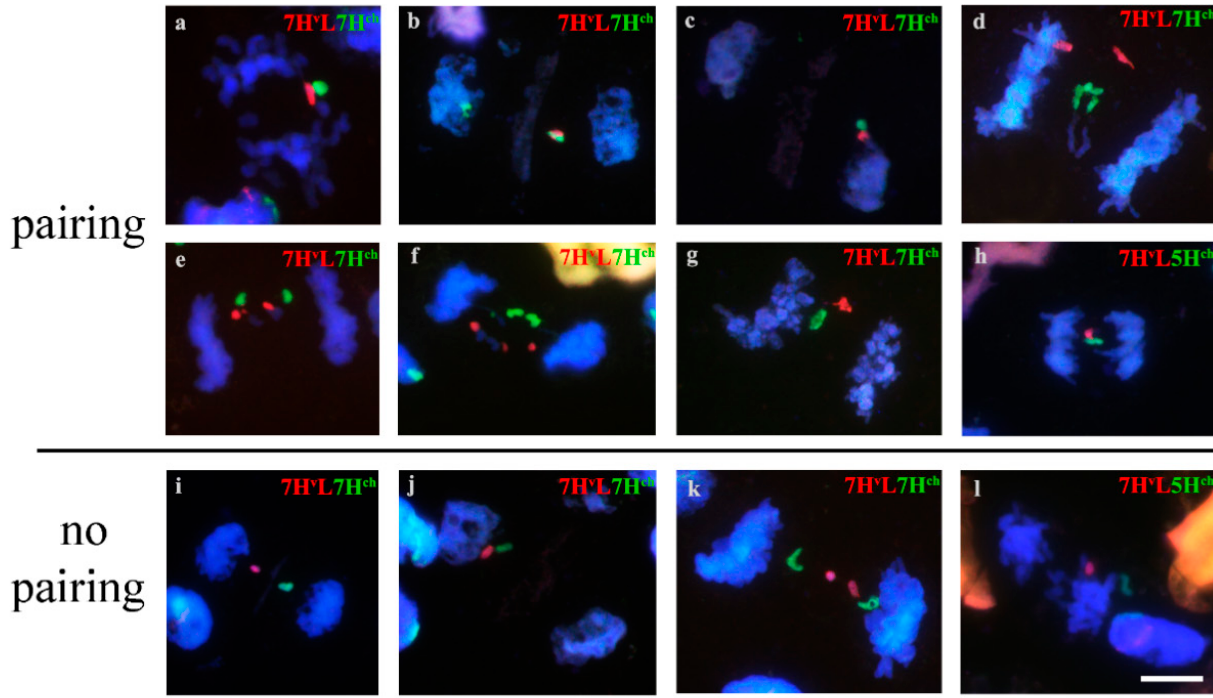
Figure 4. Chromosome segregation of barley chromosomes in double H. vulgare and H. chilense monosomic addition lines in wheat in the absence of the Ph1 locus. Examples of barley chromosome segregation are shown in both situations, whether barley chromosomes did crossover or not. Both barley chromosomes remain delayed in all situations. Hordeum vulgare and H. chilense chromosomes were visualised in red and green, respectively. DNA was counterstained.